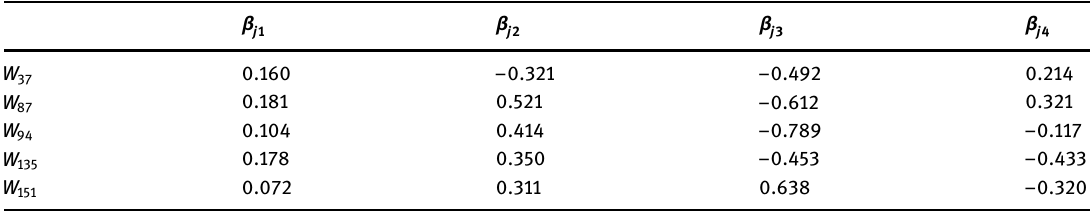
Table 2: True coe ffi cients ( β ) used in simulation